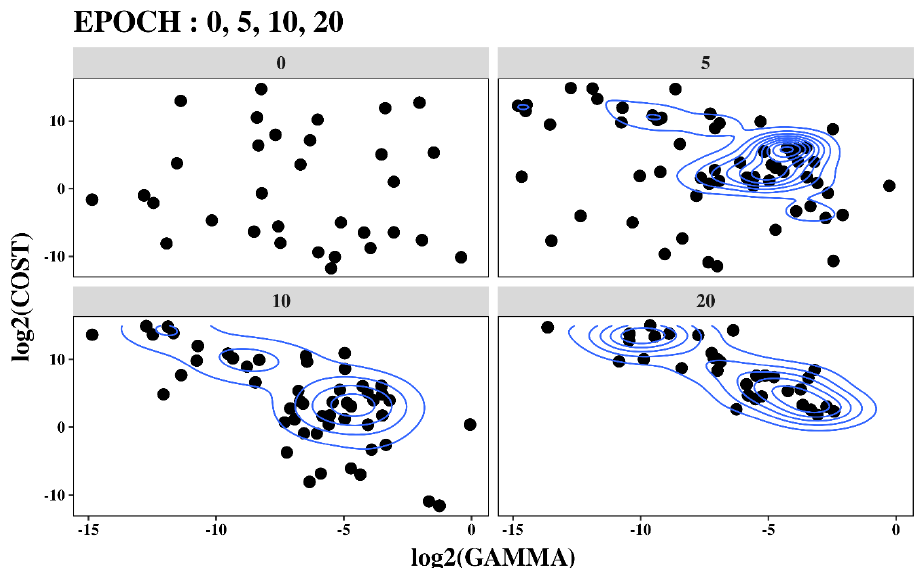
Figure 5. Optimal hyperparameters for the SVM with margin sampling in epochs 0, 5, 10, and 20 for all 150 repetitions.